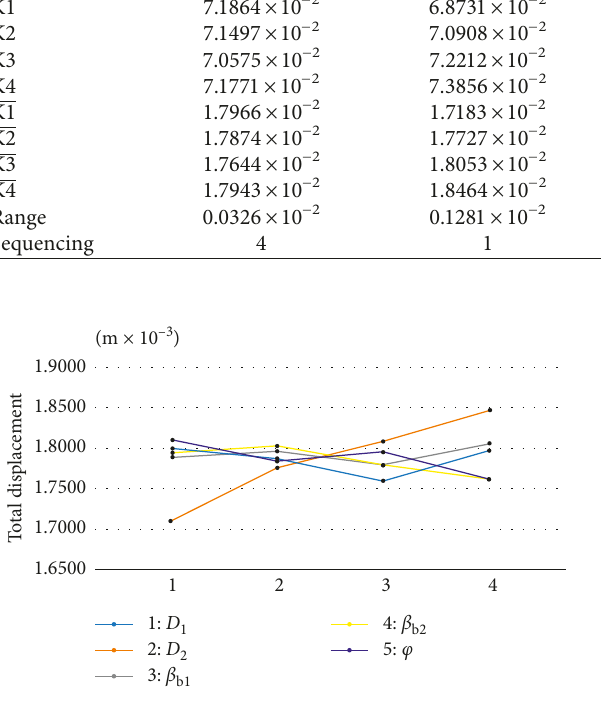
Figure 13: The influence trend of each parameter on the total displacement.